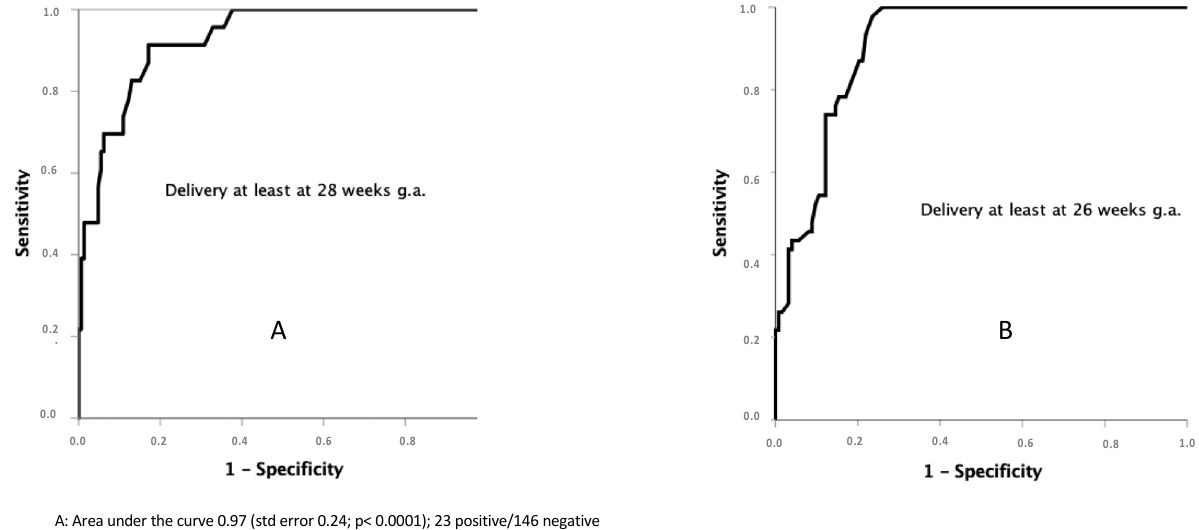
Figure 7. ROC curves for latency duration and delivery over 28 or 26 weeks. When pre-viable PPROM occurred before 17, 20 or 22 weeks the probability to deliver over the 28 weeks g.a. was 6%, 26.7%, and 65.8% respectively, and 6.5%, 27.6% and 66.7% to deliver at least at 26 weeks g.a. The overall perinatal mortality rate was 26.5%, decreasing over the period, and show- ing a significant correlation Pearson´s coefficient − 0.128 ( p < 0.05). Neonatal deaths ac- counted for 58.7% of the whole perinatal mortality, and fetal mortality was 42.3%. While in the first decade the rate was as high as 30.6%, in the period from 2011 to 2020 it was 22.3% (Figure 8).